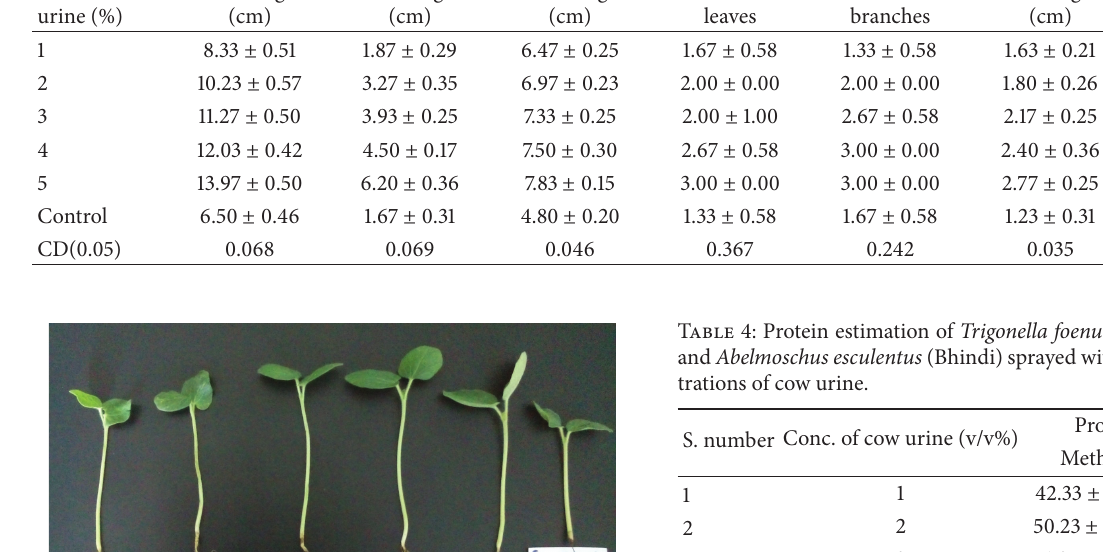
Table 3: Effect of cow urine on exomorphological characters of Abelmoschus esculentus (Bhindi) by pot culture experiment after 25 days. Conc. of cow